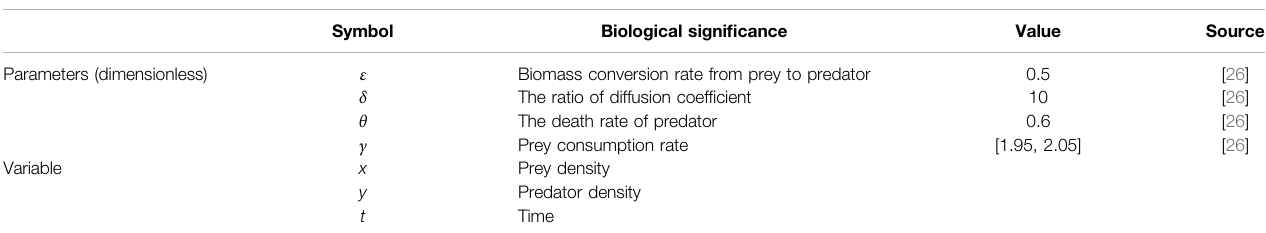
TABLE 5 | Biological signi fi cance and value of all parameters in the model